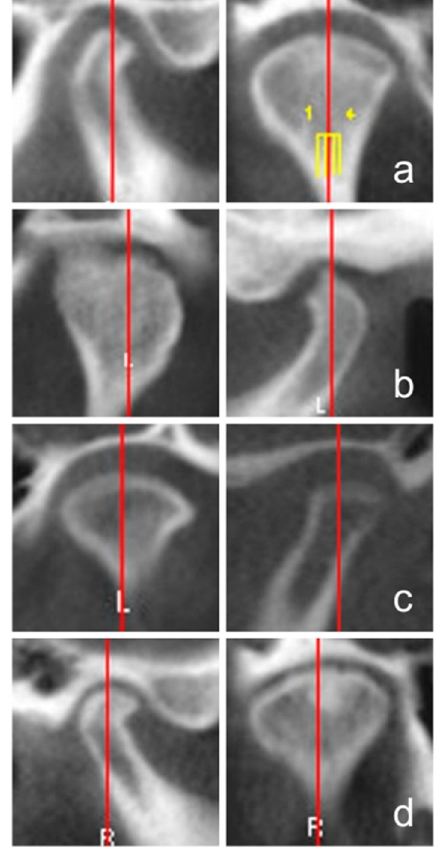
Figure 2. Representative CBCT images of the most frequent osseous changes of TMJ; flattening ( a ), surface erosion associated with surface irregularity ( b ), irregular TMJ joint space ( c ), sclerosis ( d ).